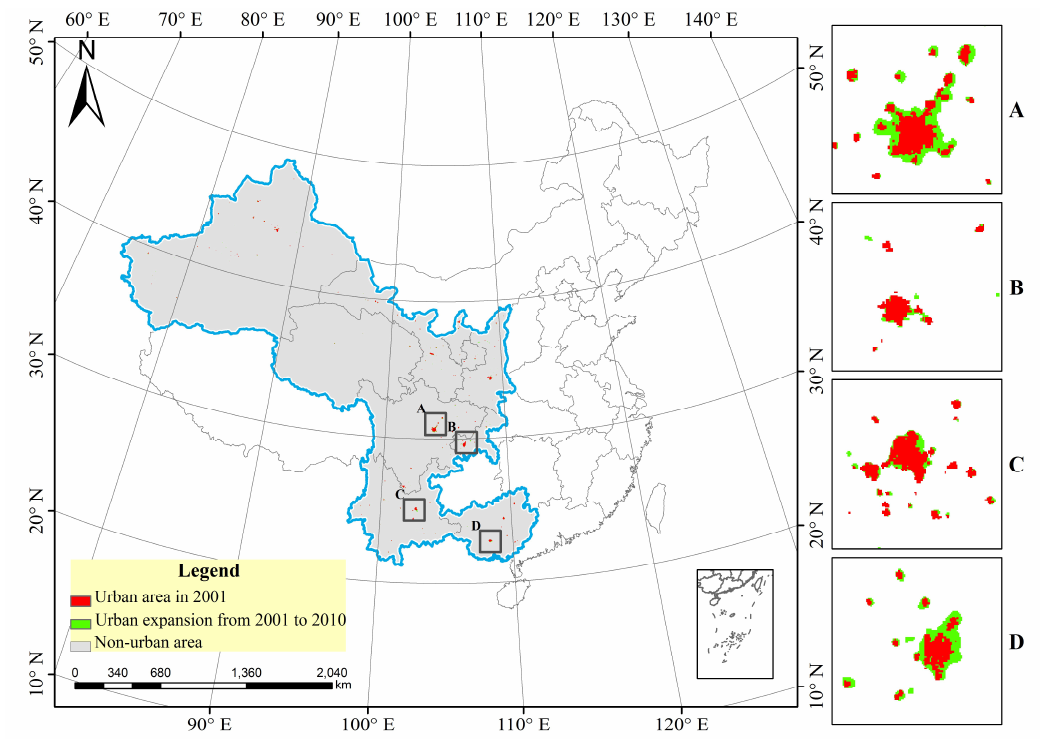
Figure 6. The dynamics of urban expansion in domestic cities, such as the local areas in ( a ) Sichuan, ( b ) Chongqing, ( c ) Yunnan, and ( d ) Guangxi, along the Silk Road Economic Belt in China from 2001 to 2010.